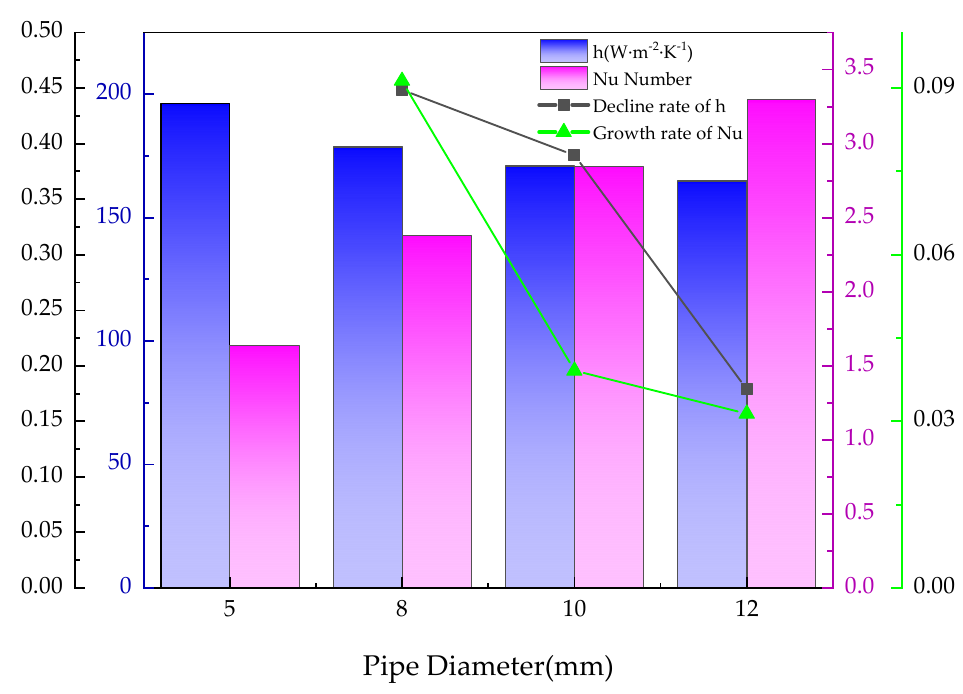
Figure 6. Effect of inlet size on h and Nu.